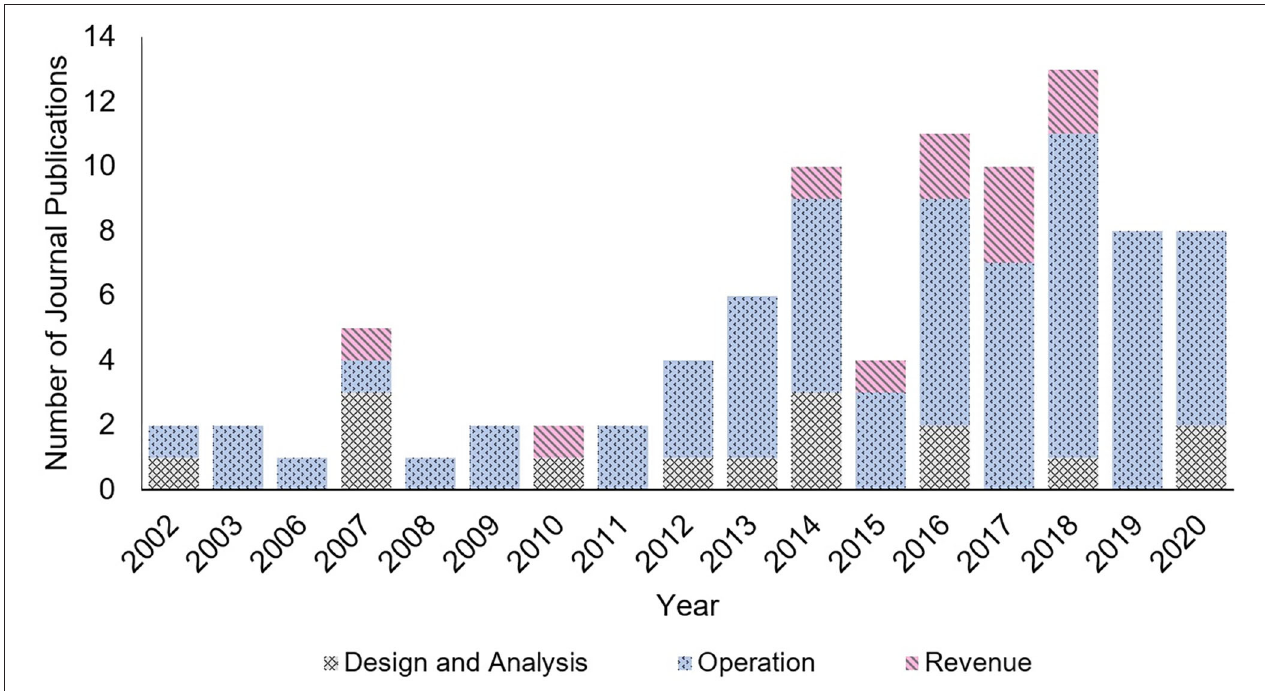
FIGURE 1 | Screened articles on Intermittent Water Supply from 2002 to